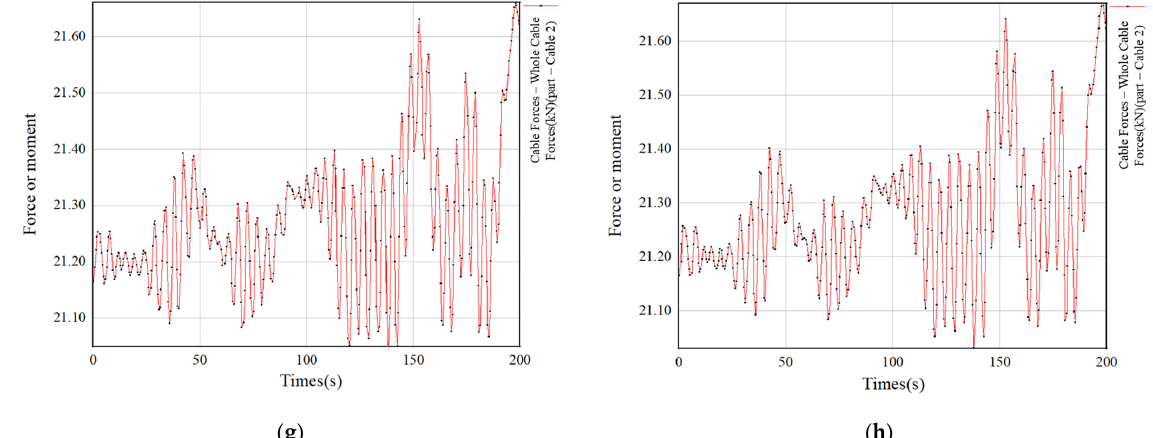
Figure 11. Dynamic change of mooring force of each anchor chain. ( a ) Dynamic change of anchor chain mooring force of floating bridge crosswise upstream No.1. ( b ) Dynamic change of anchor chain mooring force of pontoon bridge crosswise upstream No.2. ( c ) Dynamic Change of Mooring Force of No.3 Anchor Chain of Floating Bridge Transverse Upward Wave. ( d ) Dynamic Change of Mooring Force of No. 4 Anchor Chain of Floating Bridge Transverse Upward Wave. ( e ) Dynamic change of anchor chain mooring force of pontoon bridge longitudinal upstream No.1. ( f ) Dynamic Change of Mooring Force of Anchor Chain No.2 Longitudinal Upward Wave of Floating Bridge. ( g ) Dynamic Change of Mooring Force of Longitudinal Upward Wave No.3 Anchor Chain of Floating Bridge. ( h ) Dynamics of Mooring Force of No. 4 Anchor Chain Longitudinal Upward Wave of Floating Bridge.